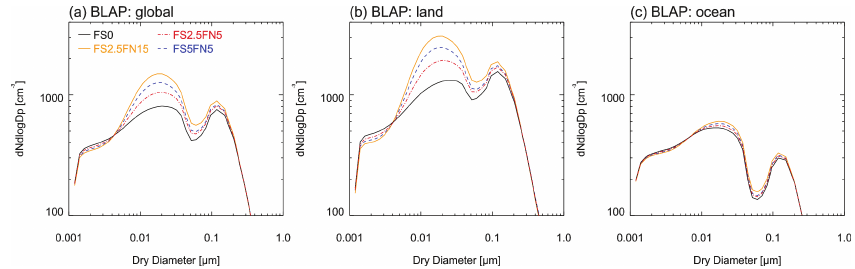
Fig. 3. Simulated boundary layer aerosol particles (BLAP) number size distributions over (a) global, (b) land, and (c) ocean. Black, red, yellow and blue curves represent the FS0, FS2.5FN5, FS2.5FN15, and FS5FN5 cases,